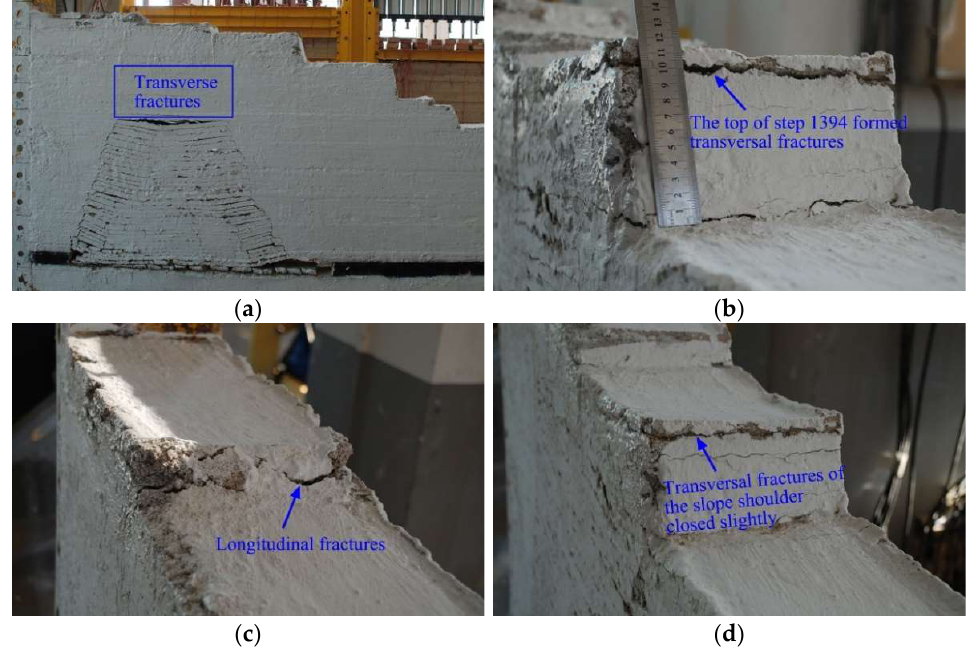
Figure 5. Horizontal and vertical fractures of the slope surface. ( a ) Development of the fracture zone ( b ) Step 1394 formed transversal fractures; ( c ) Step 1404 formed longitudinal fractures; ( d ) transver- sal fractures closed